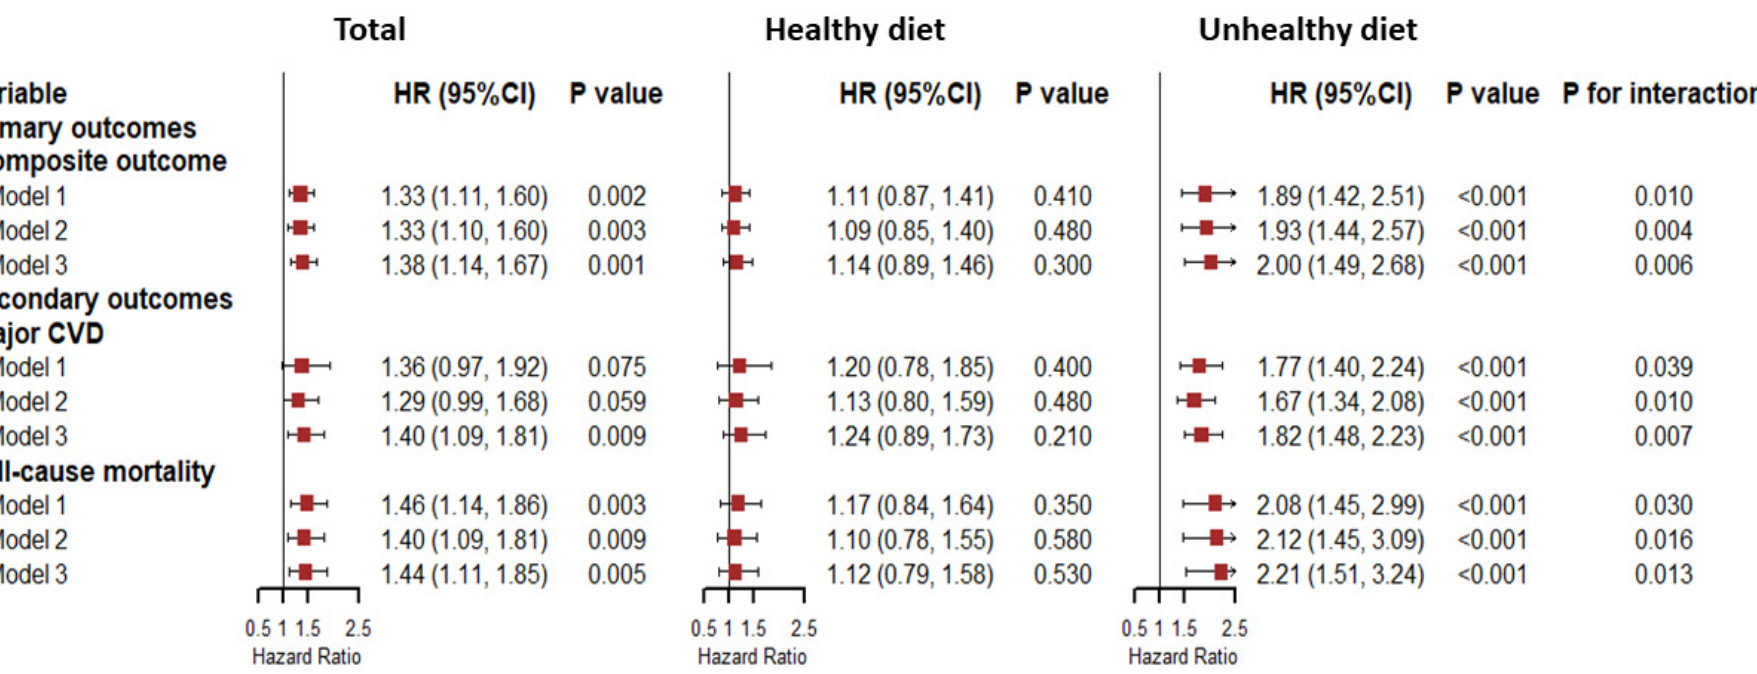
Figure 1. Forest plots for the associations between depression and the outcomes by diet. In Model 1, we adjusted for baseline age, gender, and center (as the random effect). Model 2 was further adjusted for urban/rural regions, physical activities, education level, wealth index, social isolation index, and self-reported disabilities score. In Model 3, we further adjusted baseline confounders, including current smoking, alcohol use, hypertension, diabetes, dyslipidemia, central obesity, and use of statins. Abbreviations: HR, hazard ratio; CI, confidence interval; CVD, cardiovascular disease.